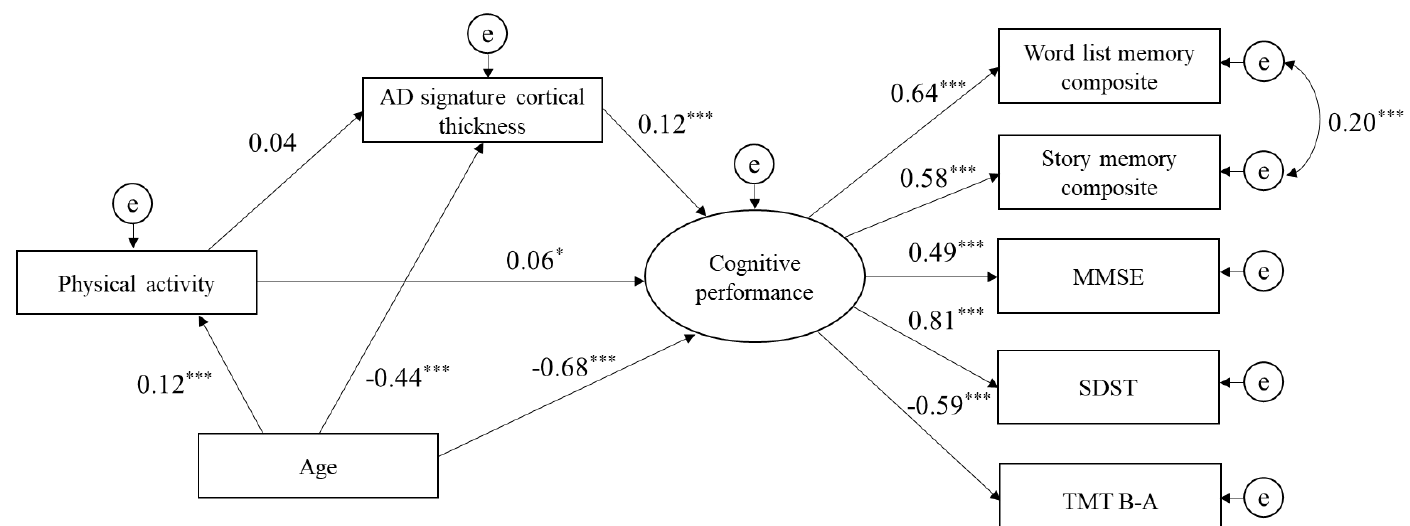
Figure 1. Structural model for associations of physical activity, AD signature cortical thickness, and cognitive performance. Goodness of fit index = 0.98, comparative fit index = 0.97, root mean square error of approximation = 0.06. e, error term; MMSE, Mini-Mental State Examination; SDST, Symbol Digit Substitution Test; TMT B-A, Trail Making Test part B minus part A. * p < 0.05, ** p < 0.01, *** p < 0.001.